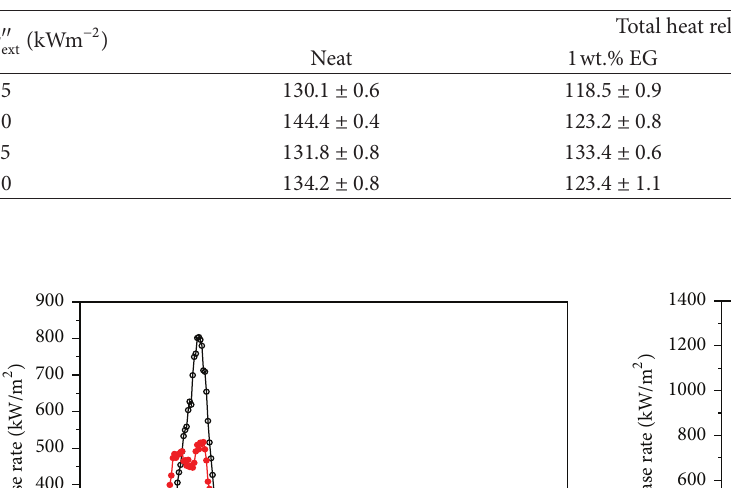
Table 3: Total heat release rate measured values of epoxy-EG composites from external heat fluxes.